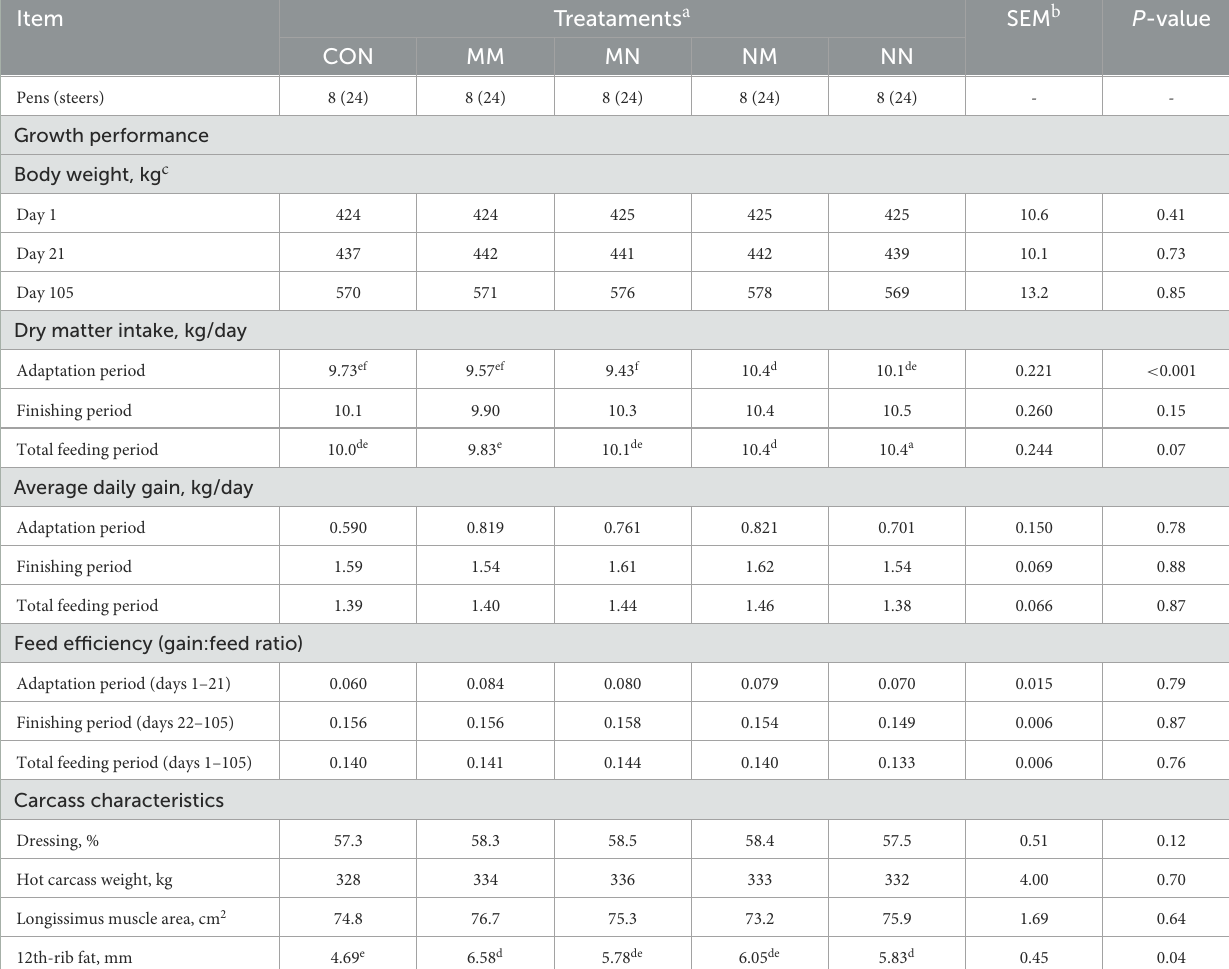
TABLE 6 Effect of feed additives on growth performance and carcass characteristics of finishing beef cattle—Exp.